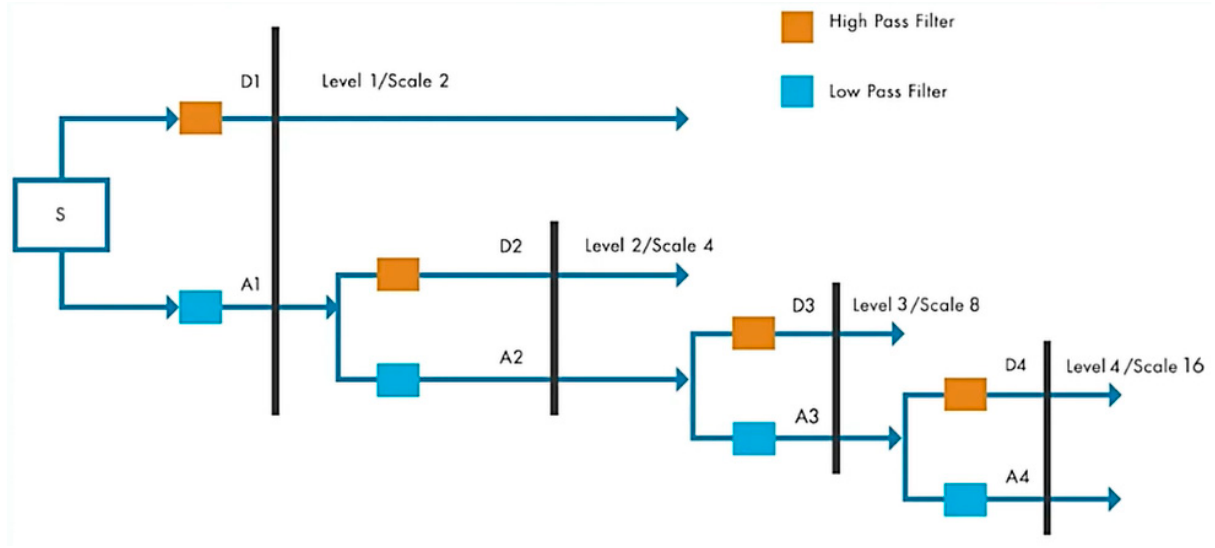
Figure 4. Frequency bands of the discrete wavelet transform related to decomposition steps [35].